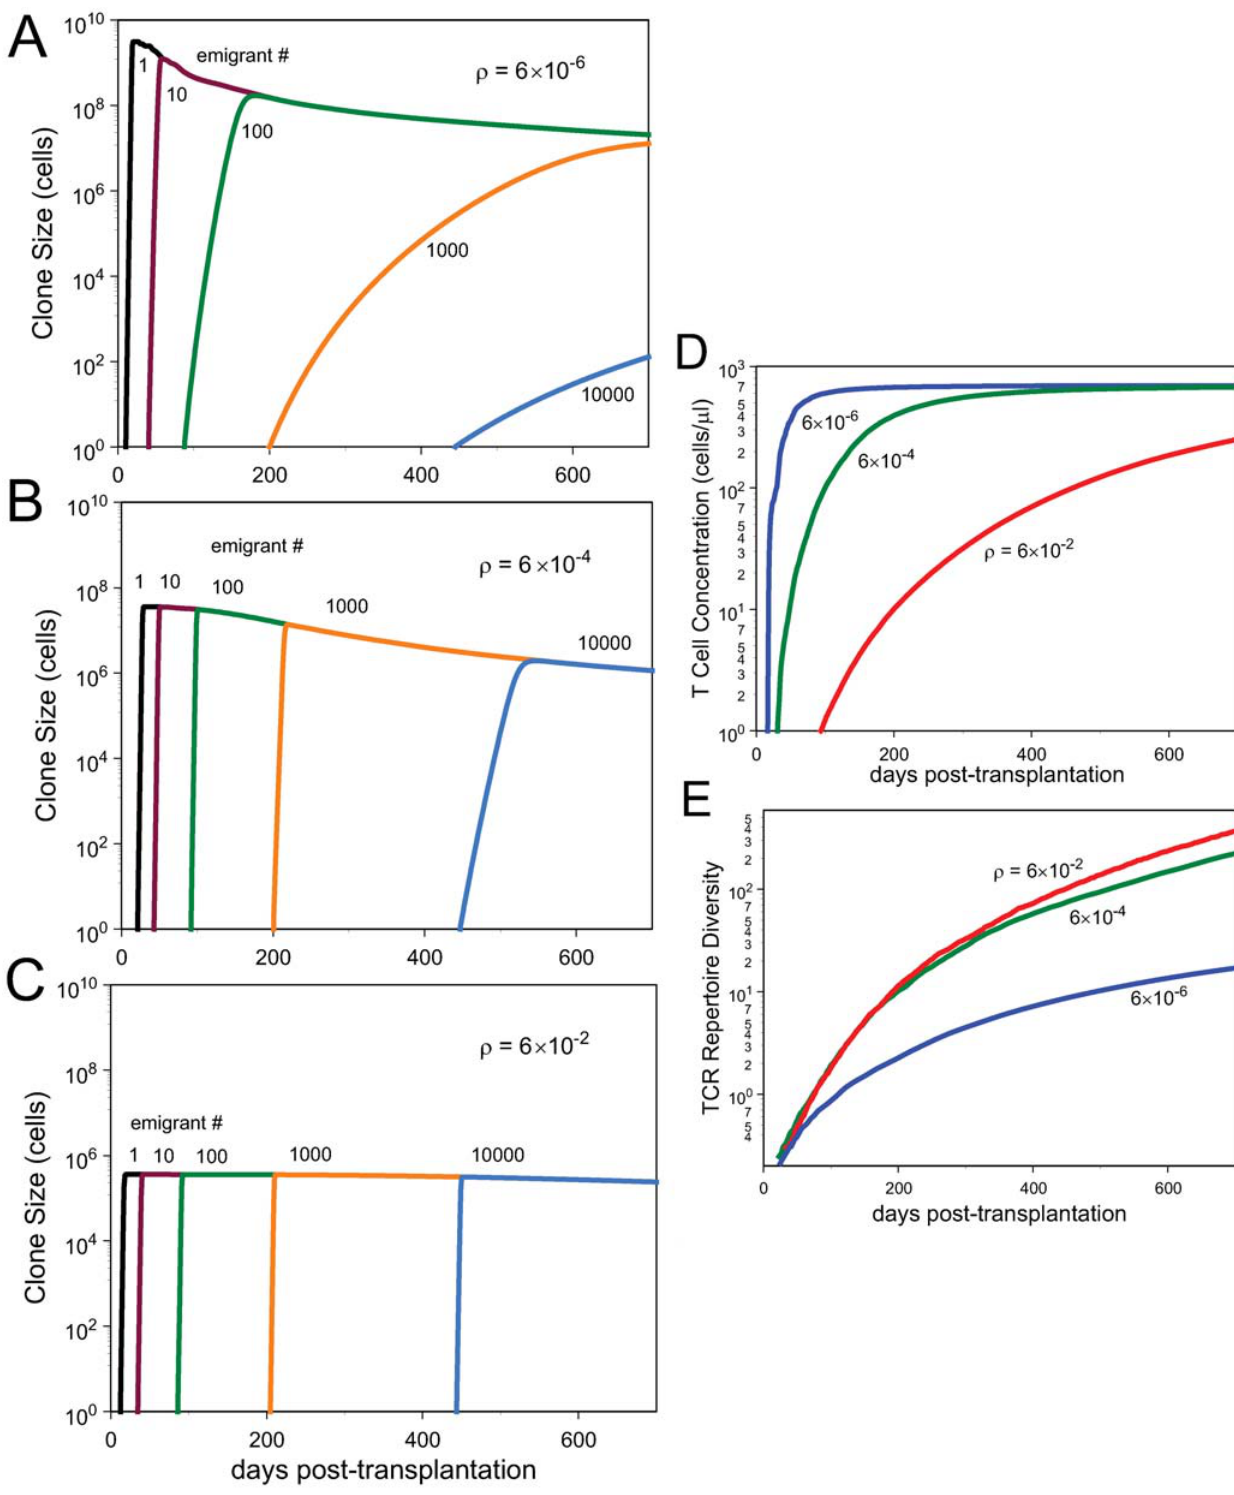
Figure 1. Clone sizes, T cell concentrations and TCR repertoire diversity. Clone sizes over time as computed under the model of Eqs.(1,4) (A–C) and the corresponding T cell concentrations (D) and TCR repertoire diversity (E) as a function of time past transplantation. computed under the model of Eqs.(1,4) as a function of time past transplantation. Parameter r (see Model section) is varied as indicated while all other parameters are held constant. The higher r , the more limiting are TCR-specific resources. ‘‘Emigrant number’’ refers to the order in which clones leave the thymus and enter the periphery; emigrant number 1 is the first clone to arise, etc.